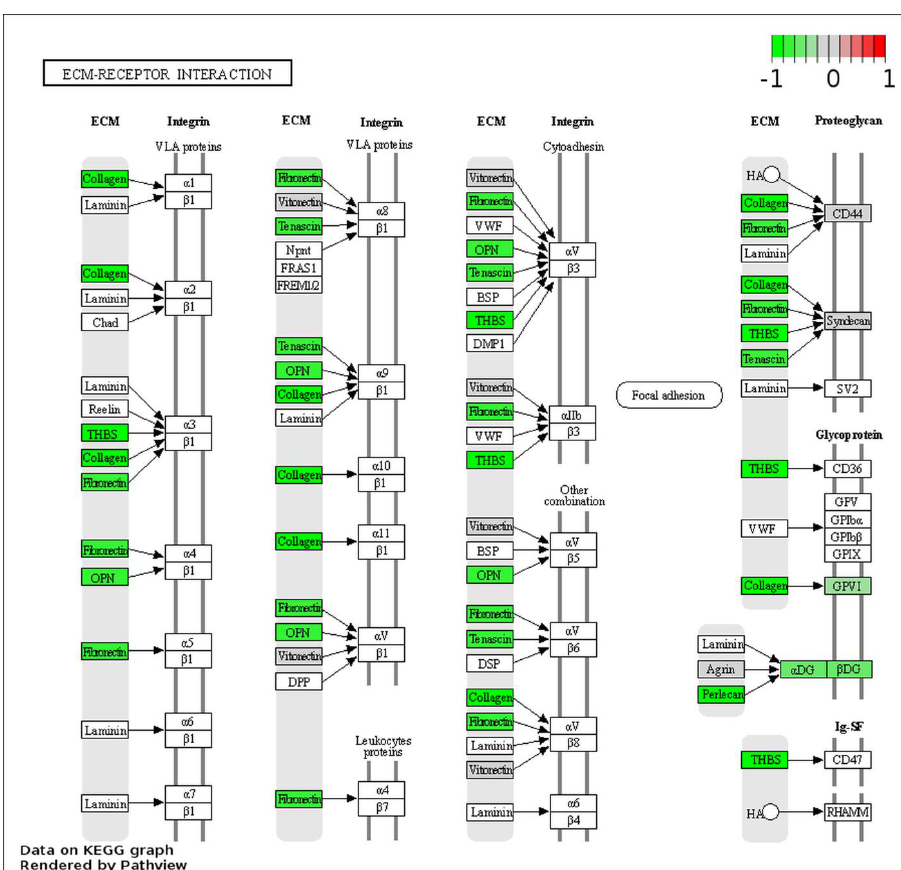
Figure 5. Regulation of genes involved in ECM-receptor interaction (KEGG pathway: 04512). Colored boxes represent differentially expressed genes found in this pathway. The colorbar indicates scaled, log 2 -fold change values (red for upregulated, green for downregulated) in the gene expression of CIN3, in comparison to the control group.